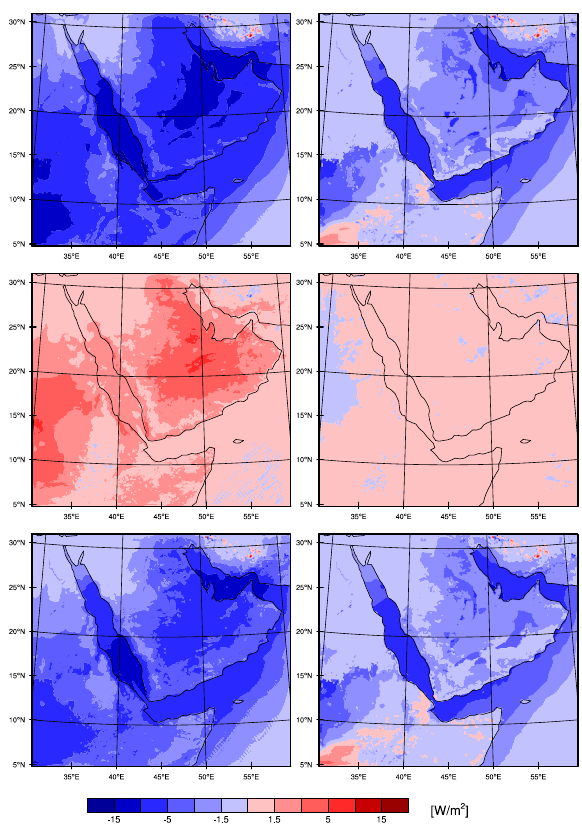
Fig. 9. Clear sky daily averaged SW (upper row), LW (middle row), and SW + LW (lower row) radiative forcing of dust [Wm − 2 ] at the surface (left column) and at TOA (right